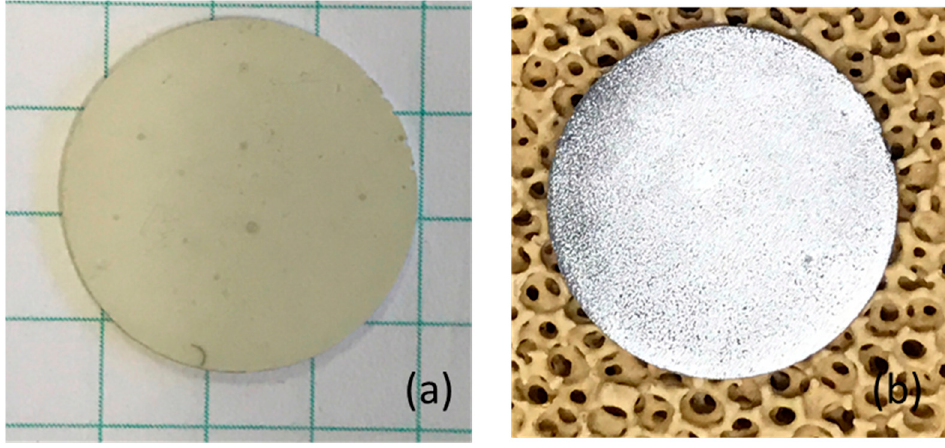
Figure 9. ( a ) A sample of Ag- β″ -alumina + YSZ. ( b ) The sample after heat treating at 900 °C in air showing metallic color.